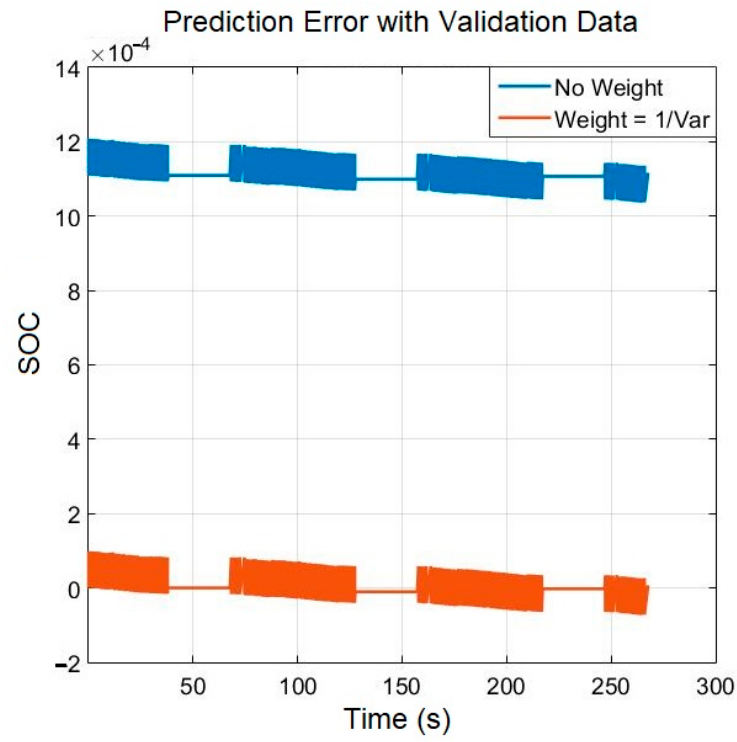
Figure 10. Prediction error regarding state of charge. Table 6. Mean and RMS values of the prediction error (state of charge) .